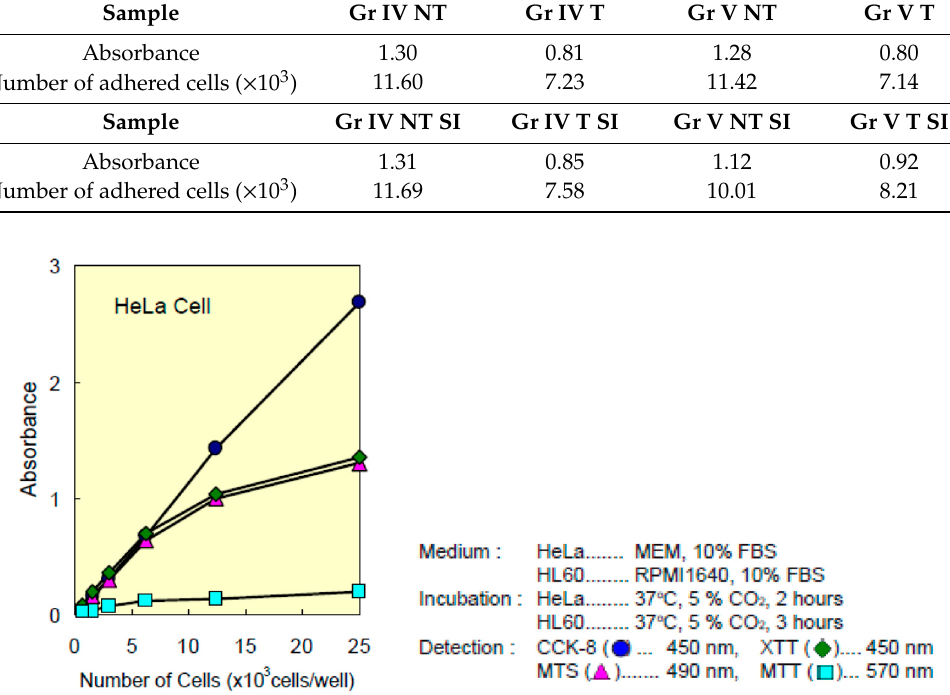
Figure 14. Graph of the results of culture of mother cells on di ff erent samples. Table 12. Absorbance and number of cells arising from the result on the samples studied in cell culture.